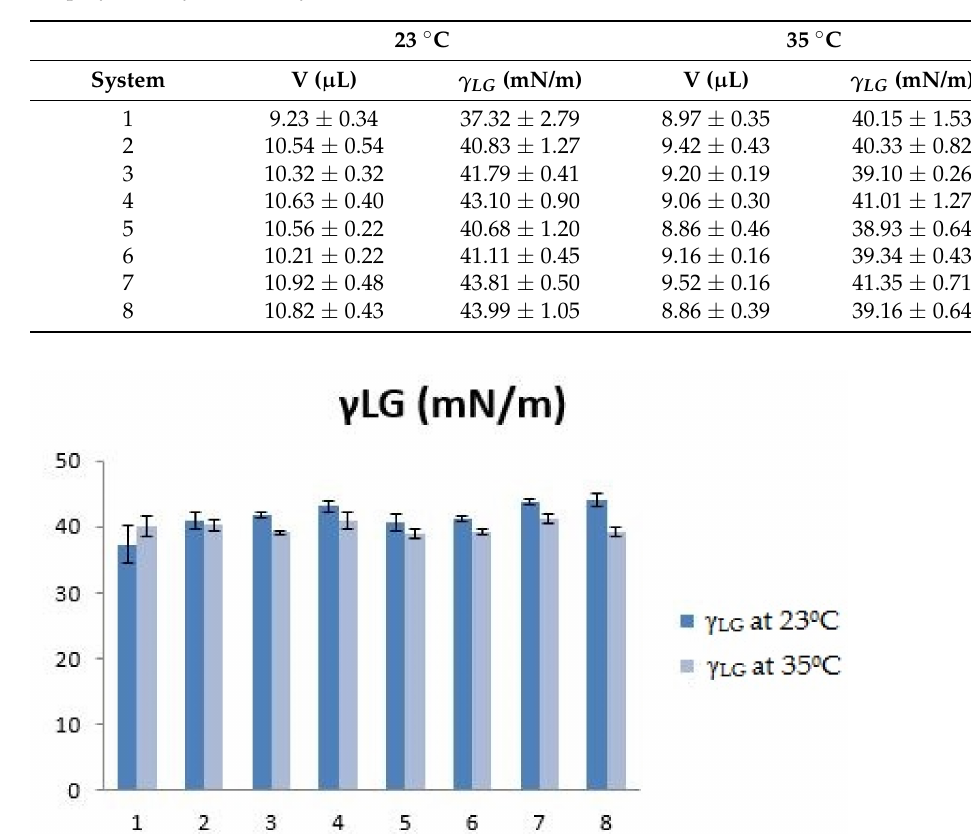
Table 5. Synthesis of experimental data resulting from the evaluation of the surface tension γ LG for the polymeric systems analyzed at 23 ◦ C and 35 ◦ C.